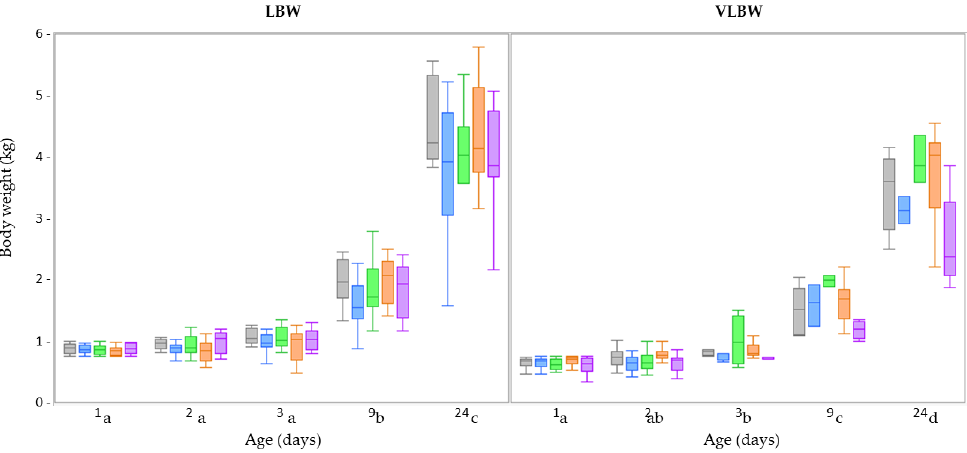
Figure 1. Boxplots of the body weight at different time points (day of birth [day 1], day 2, day 3, day 9, and day 24 [two days after weaning]) of very low birth weight (VLBW; n = 80) and low birth weight (LBW; n = 80) piglets per treatment (dense milk replacer [DMR] one dose [grey box], DMR three doses [blue box], no treatment [green box], sham one dose [orange box], sham three doses [purple box]) at Farm A. There was no effect of drenching DMR on body weight ( p = 0.179). Body weight increased during the experimental period independent of treatment and birth weight category ( p < 0.001). Ages carrying a different subscript letter were significantly different. Table 3. Comparison of average daily growth (ADG), factorial growth, metabolic weight and facto- rial metabolic rate of low birth weight (LBW) with very low birth weight (VLBW) piglets at days 1, 2, 3, 9 and 2 days post-weaning (24 days) at the farm with low perinatal management (Farm A (me- dian ± SD)).